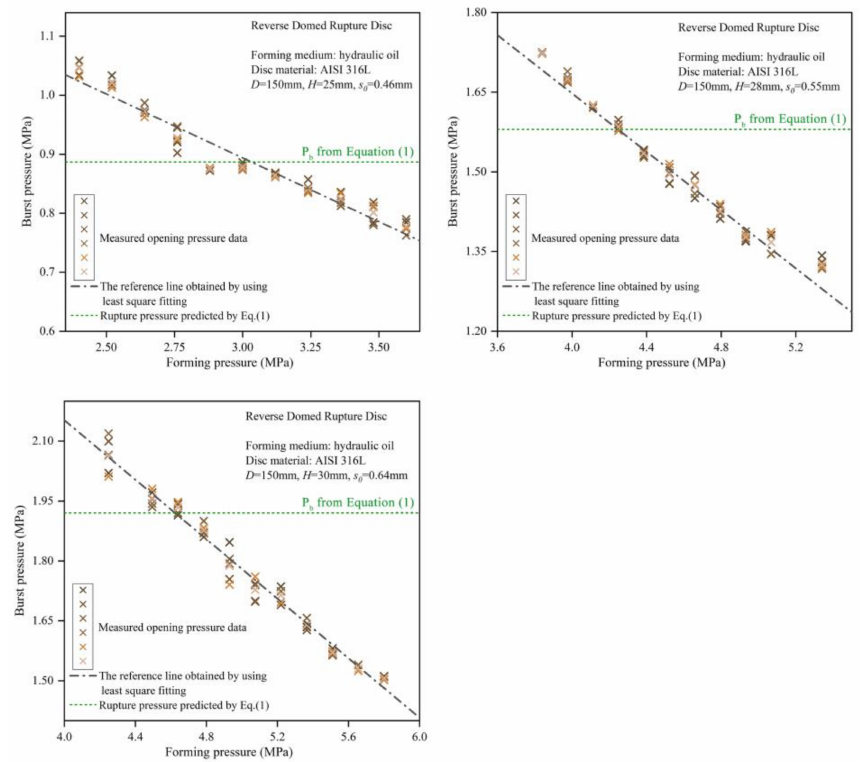
Figure 12. For the hydraulic forming method, the relationship between the burst pressure and the forming pressure of rupture discs with a diameter of 150 mm.